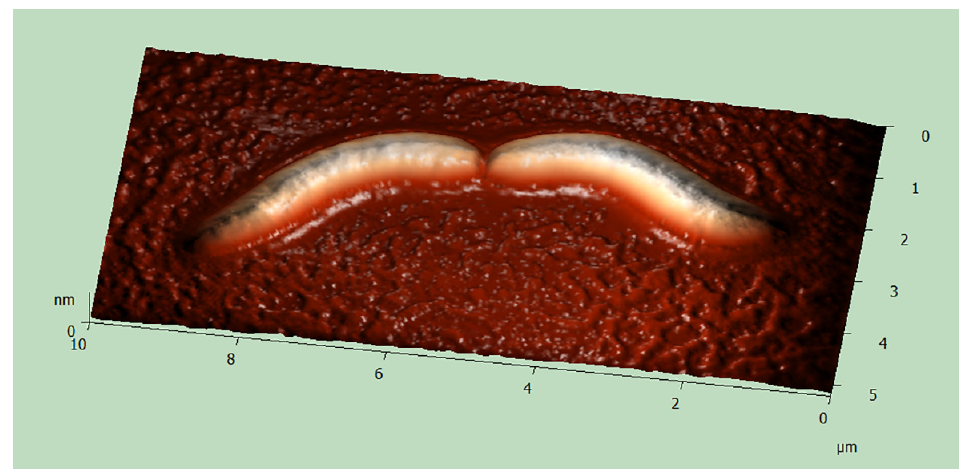
Figure 3. 3D reconstruction of CS-bacterium released from the cytoplasm of P. nephridiatum strain BMS16-23, AFM.